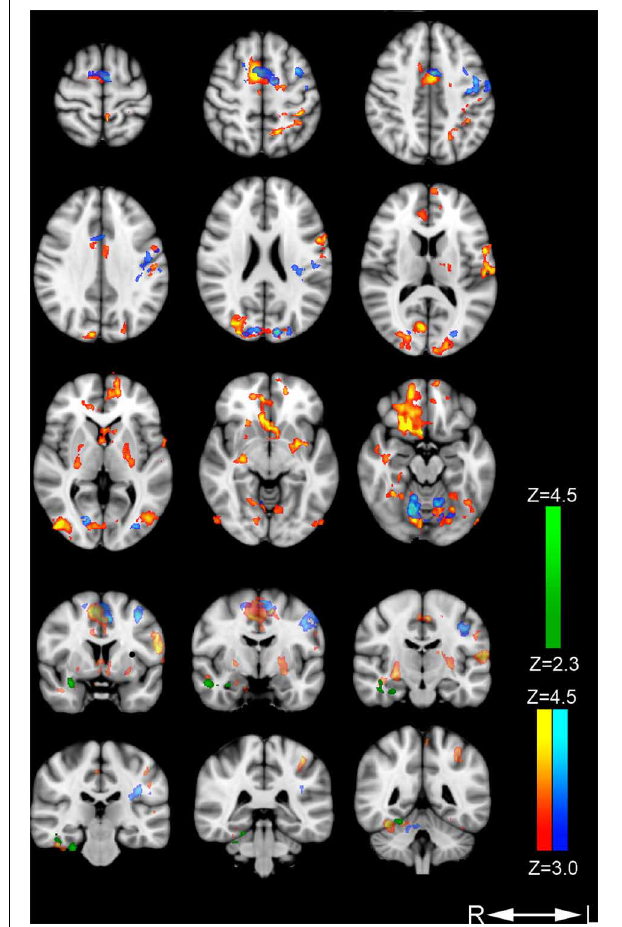
FIGURE 1 | Areas with increased cerebral activation. Color-coded regions show activation above threshold in the following contrasts: Nondirective meditation > rest (red-yellow), concentrative practicing > rest (dark blue-light blue), and nondirective meditation > concentrative practicing (dark green-light green). Activations are superimposed on MNI template (Montreal Neurological